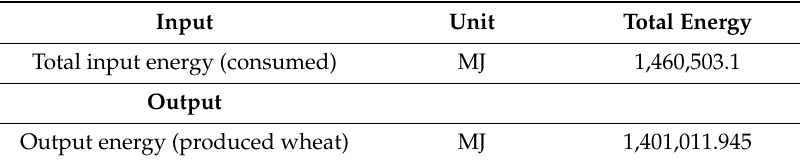
Table 5. Input and output energy